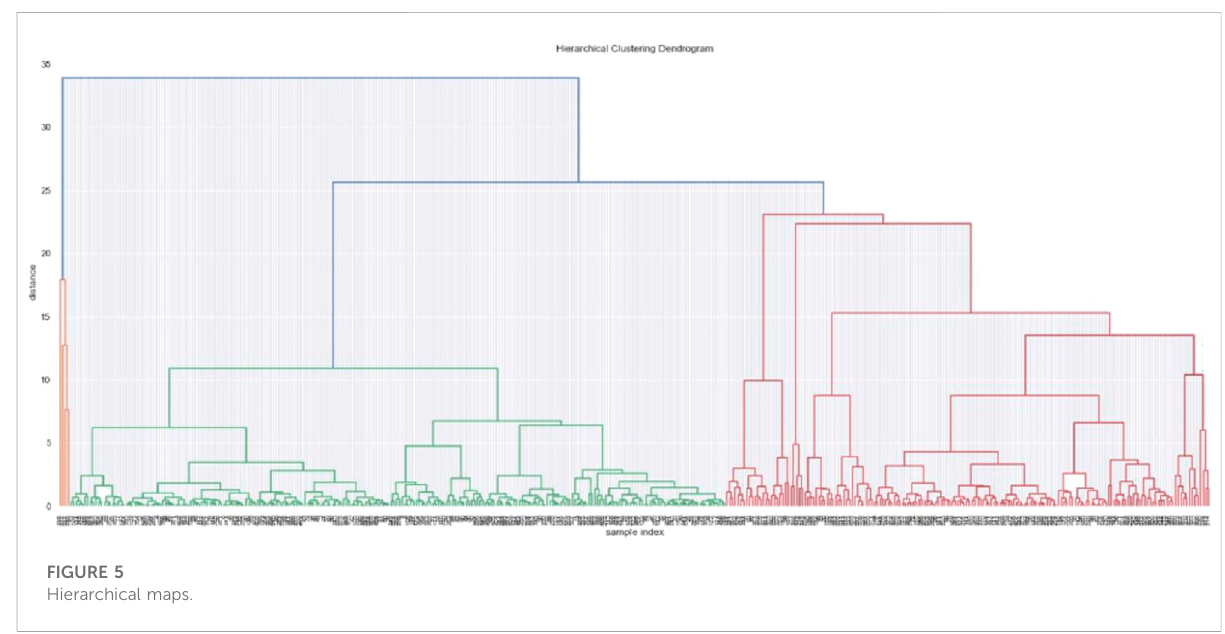
FIGURE 5 Hierarchical maps.